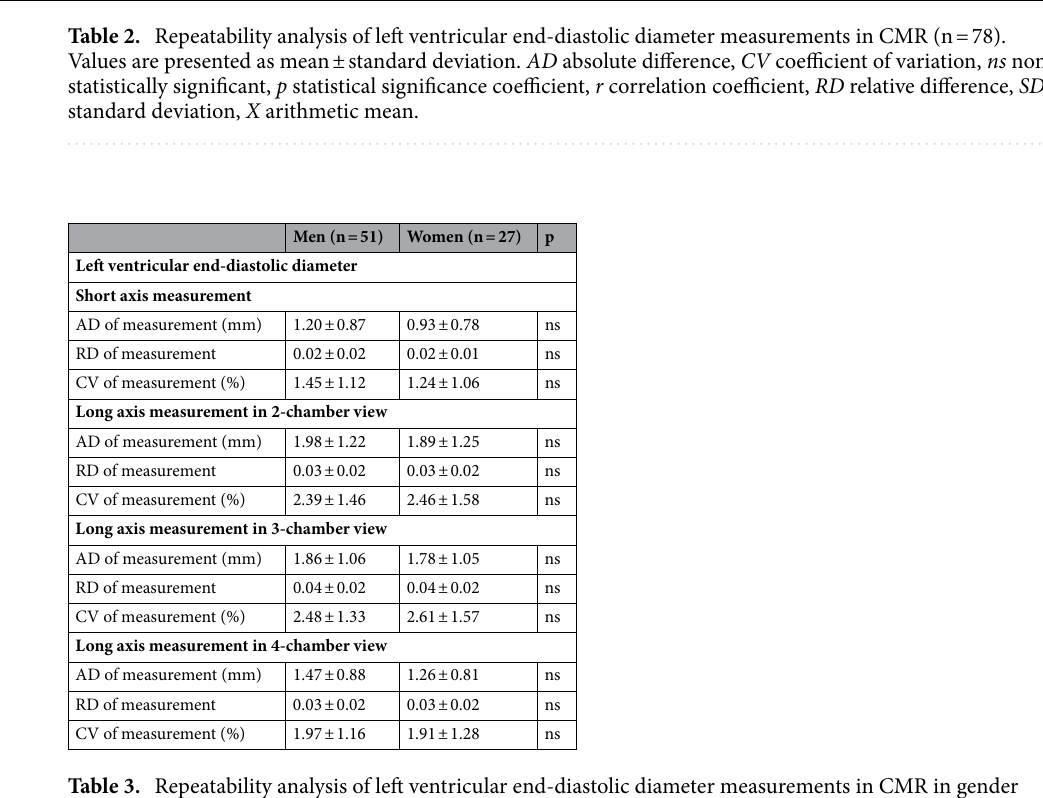
Table 3. Repeatability analysis of left ventricular end-diastolic diameter measurements in CMR in gender subgroups. Values are presented as mean ± standard deviation; AD absolute difference, CV coefficient of variation, RD relative